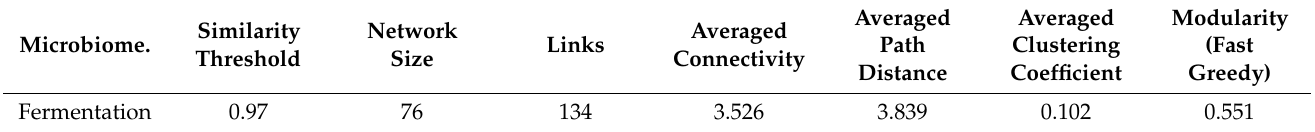
Table 1. Major topological properties of the empirical networks.